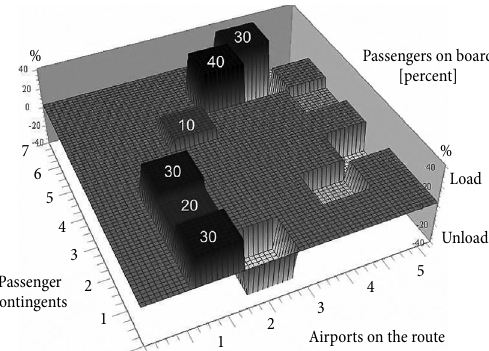
Fig. 8. Loads and unloads in each airport on the route